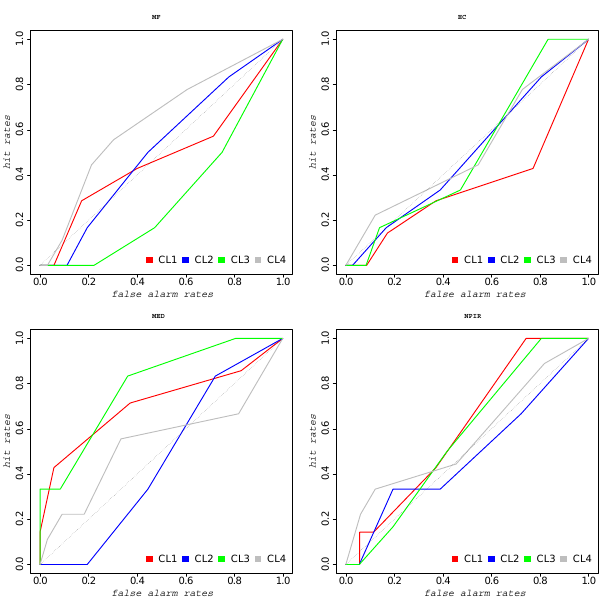
Fig. 5. Z500 ROC curves (false alarm rates in abscissa, hit rates in ordinate) for each cluster, from each forecast set.